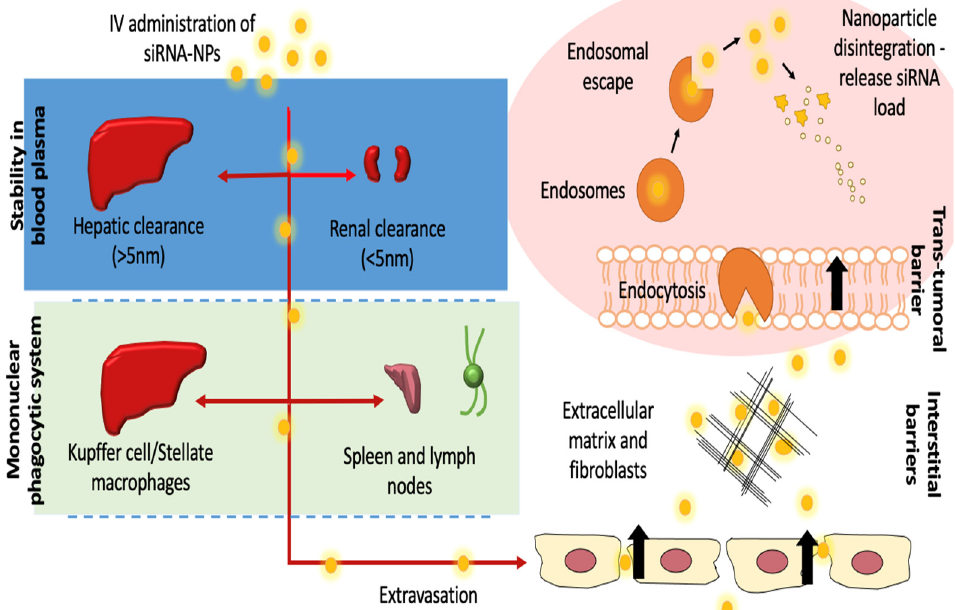
Figure 4. Physiological barriers to in vivo delivery of siRNA-nanoparticles. Extracellular barriers include hepatic and renal clearance, which are dependent on the particle sizes. Opsonization and macrophage engulfment via the mononuclear phagocytic system (MPS) further reduce the bioavailability of siRNA nanoparticles in the plasma. Extracellular matrix (ECM) trapping further decreases the localization of siRNA complexes into the tumor tissues. Intracellular barriers involve effective endosomal escape and siRNA release into the cytosol to initiate RNAi-associated gene knockdown activity.